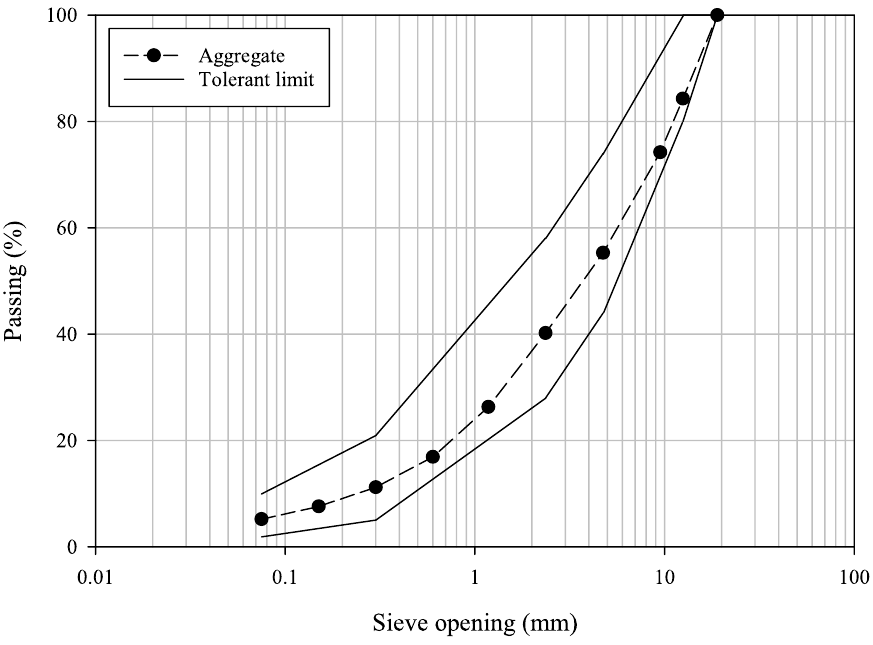
Figure 1. Grain size distribution curves of aggregate. Table 1. Properties of aggregate.